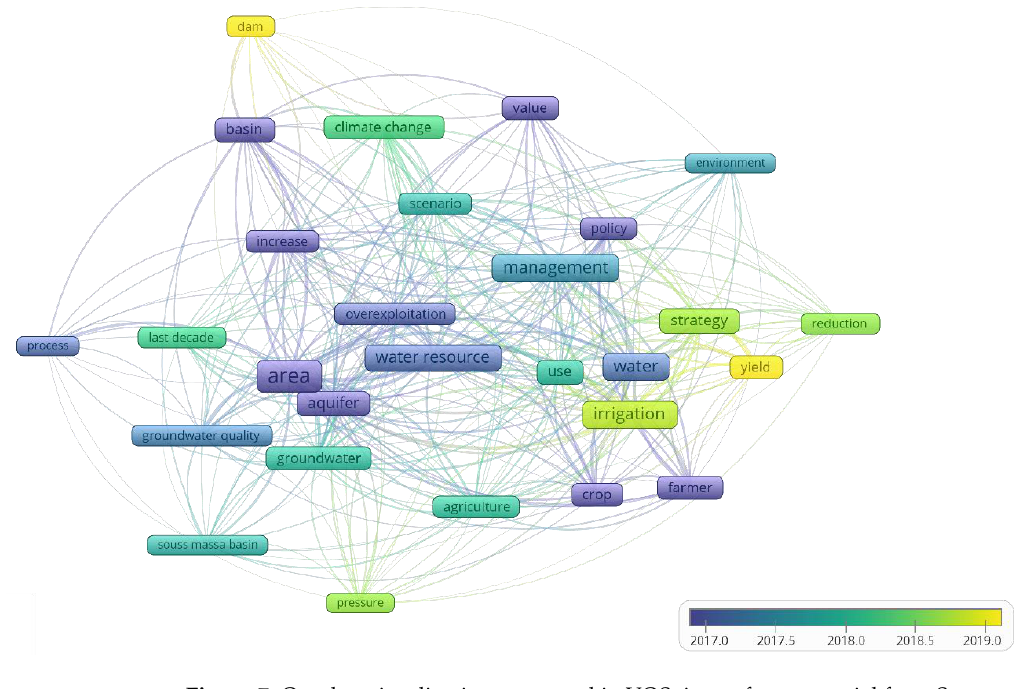
Figure 7. Overlay visualization generated in VOSviewer from material from Scopus and WOS based on the abstracts analysis.